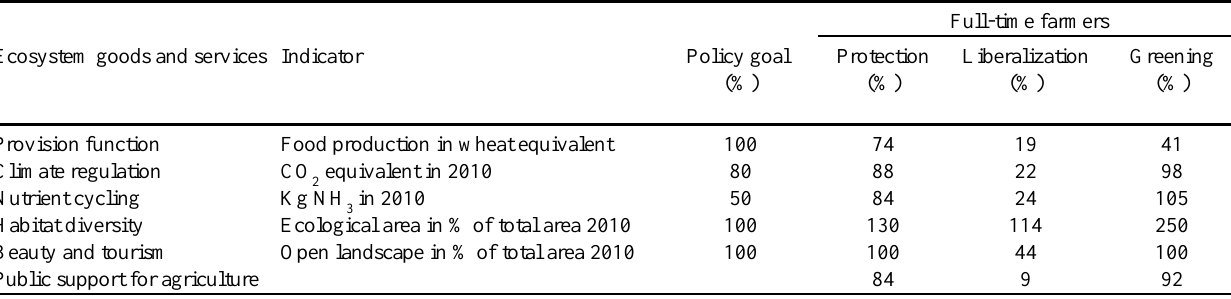
Full-time farmers Protection Liberalization Greening (%) (%) (%) (%)